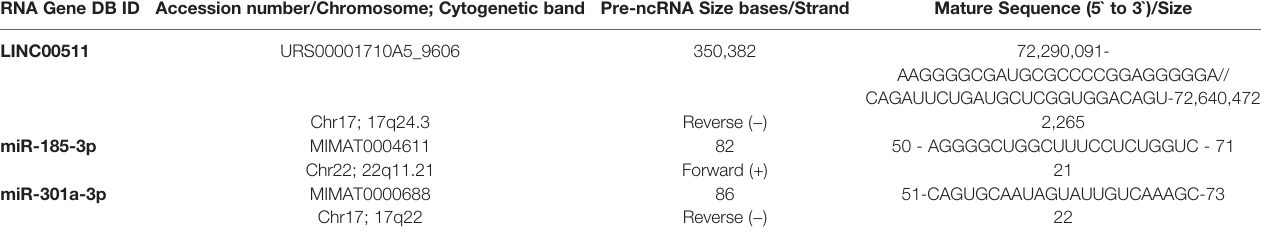
TABLE 1B | LINC00511, miR-185-3p, and miR-301a-3p accession number, chromosome, cytogenetic band, size bases, strand, mature sequence, and sequence size obtained from databases (DB). RNA Gene DB ID Accession number/Chromosome; Cytogenetic band Pre-ncRNA Size